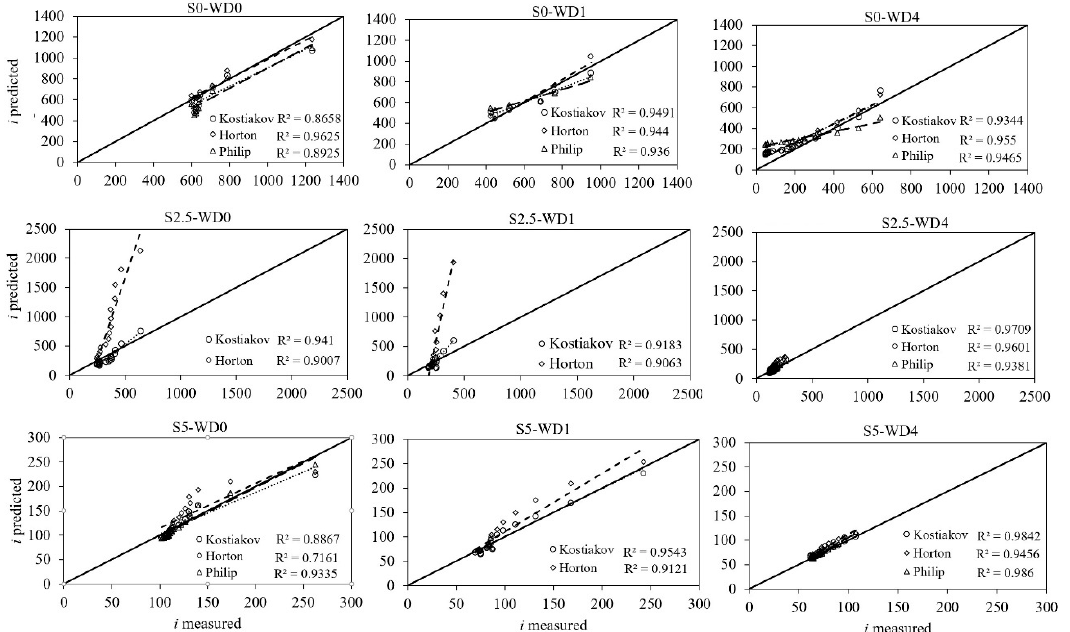
Figure 3. Scatter plot of the observed and predicted infiltration rate i (mm / h) using the Kostiakov, Philip and Horton models for the sandy (S) treatments (S0, S2.5 and S5) for two extreme wetting and drying (WD) cycles WD1 and WD4, compared to WD0. The diagonal represents the line of best fit.